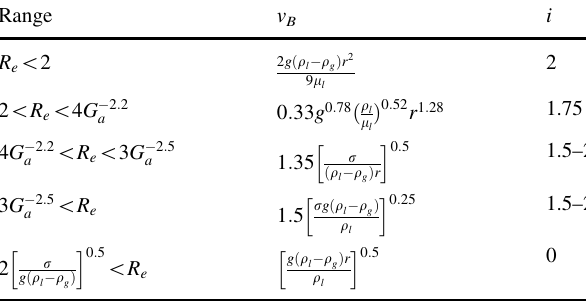
Table 1 Expressions and terminal velocity indices for free upward- floating bubbles Range v